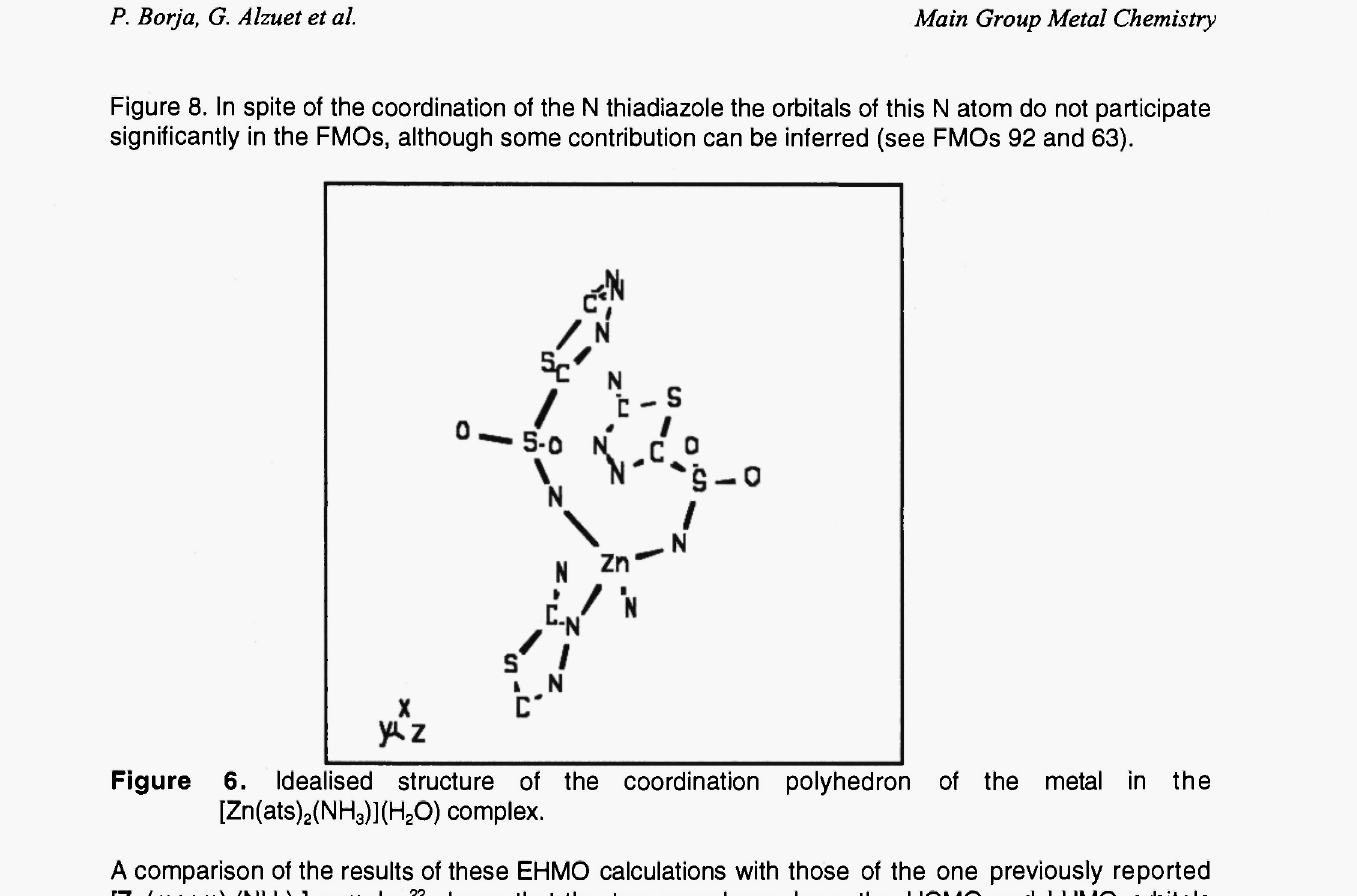
Figure 8. In spite of the coordination of the Ν thiadiazole the orbitals of this Ν atom do not participate significantly in the FMOs, although some contribution can be inferred (see FMOs 92 and 63).